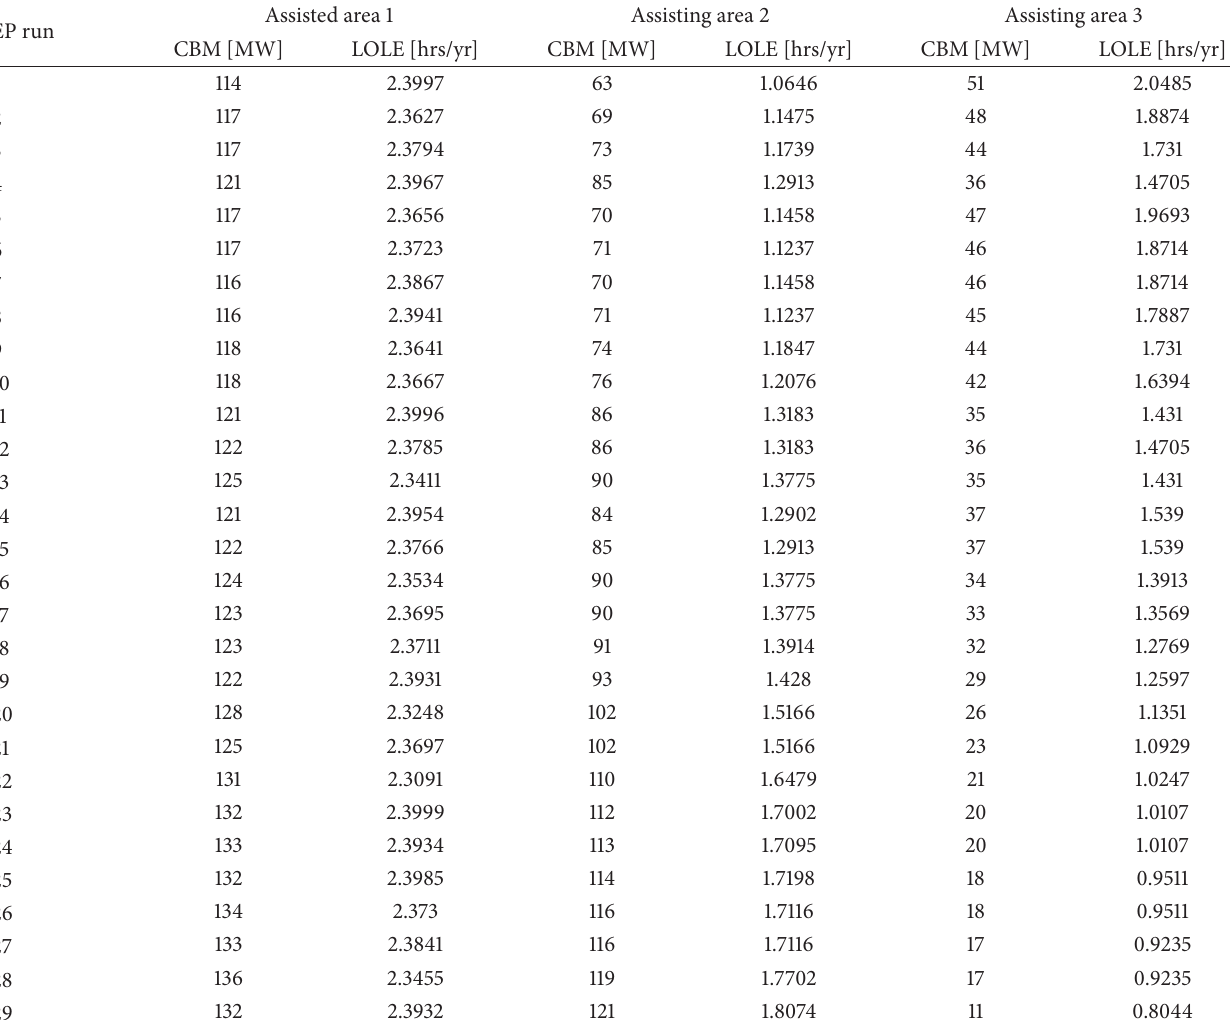
Table 5: Pareto optimal front of CBM values for each